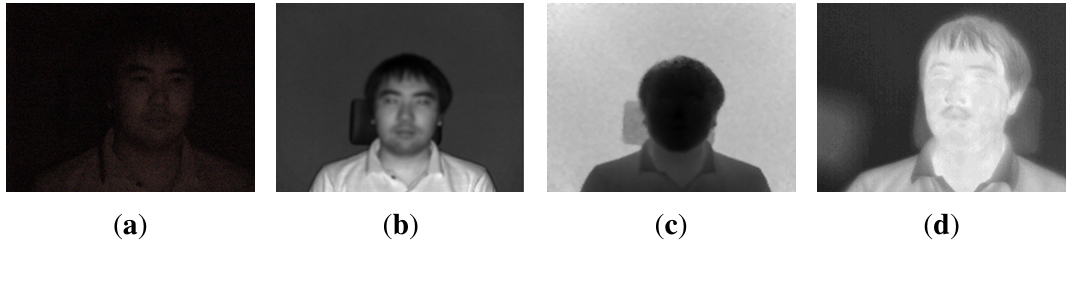
Figure 2. Captured images in a lightless condition; ( a ) visible range image; ( b ) near-infrared (IR) image from the time-of-flight (ToF) camera; ( c ) distance image from the ToF camera; and ( d ) thermal-IR